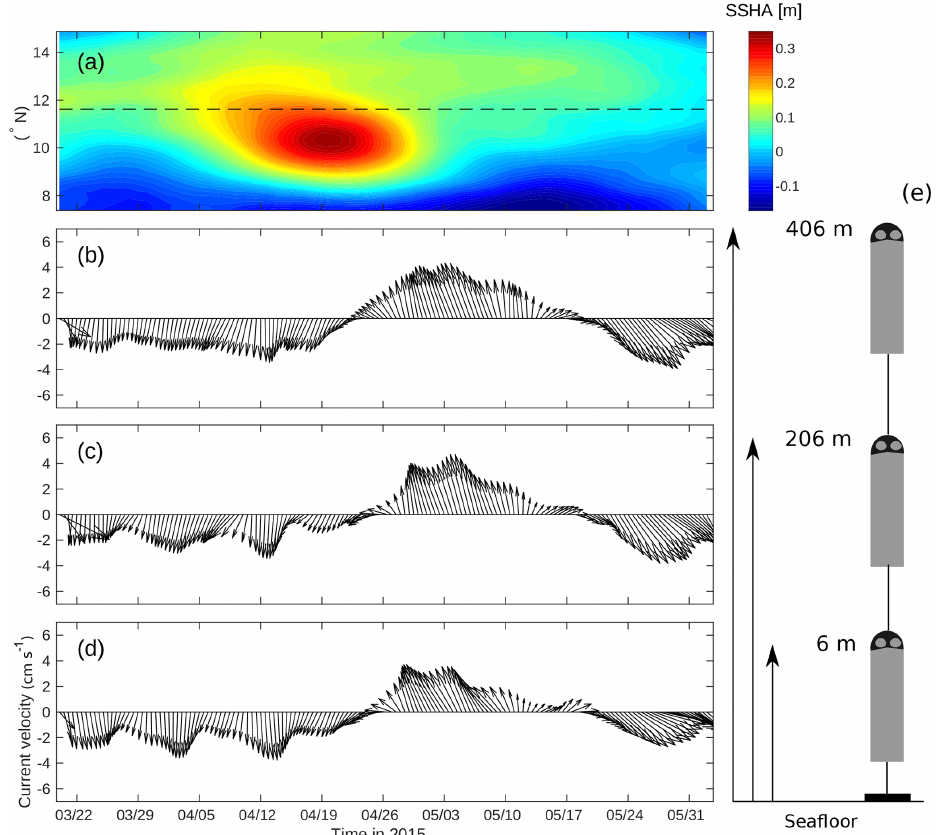
Figure 10. (a) Temporal evolution of the SSHA at a zonal transect in the SR from 7 ◦ to 15 ◦ N from 20 March to 2 July 2015. Ocean current velocity recorded by an array of single-point Aquadopp current meters at 406m above the seafloor (b) , at 206m above the seafloor (c) , and at 6m above the seafloor (d) . These heights above the seafloor correspond to 3788, 3971, and 4180m water depth. (e) A schematic figure of the current meter array. The dashed black line in (a) shows the latitude where the geographical center of the moorings is located. All current velocities are averaged over a half-day period and shown